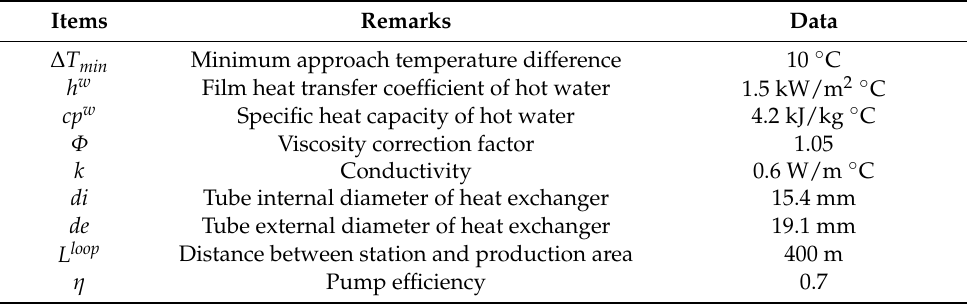
Table 4. Physical parameters of the case.